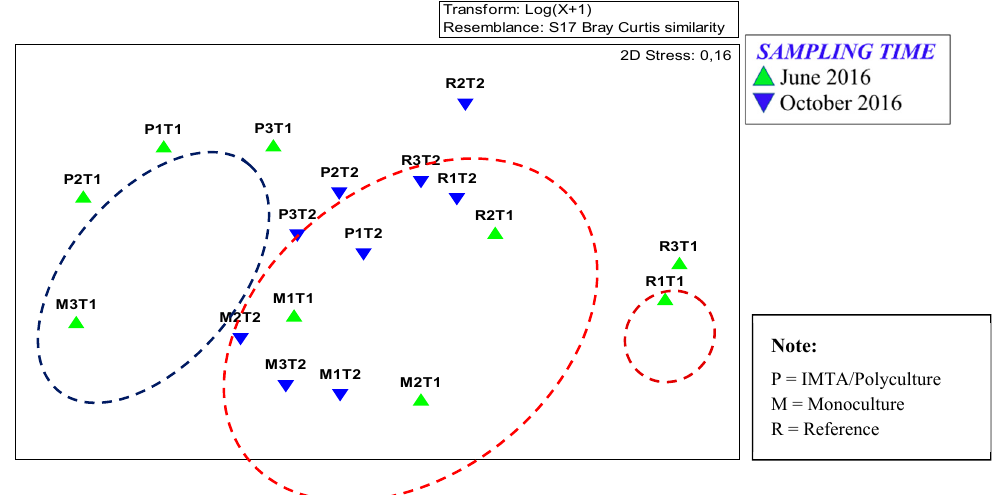
Figure 4. The 2D ordination of NMDS based on sampling time. Note: red, dashed circle: tendency of mixed grouping/clustering at the stations of , monoculture, and reference site; brown, dashed circle: tendency of separate stations of reference site; blue circle dashed line: tendency of separate stations of monoculture and sites.